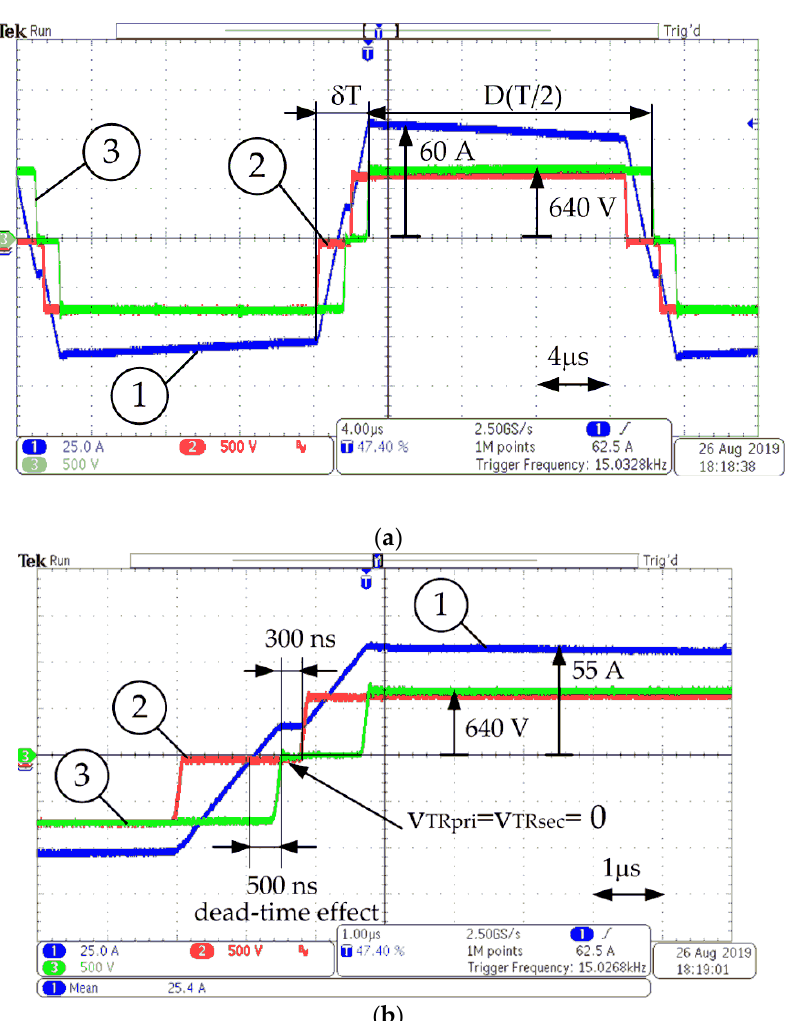
Figure 14. Measured waveforms of the DAB DC-DC converter with the second MFT prototype: primary transformer current i TR_pri (1), 25 A/div; primary voltage v TR_pri (2), 500 V/div; secondary voltage v TR_sec (3), 500 V/div at the rated load. Time scale 4 µs/div. ( a ) and 1 µs/div. ( b ).